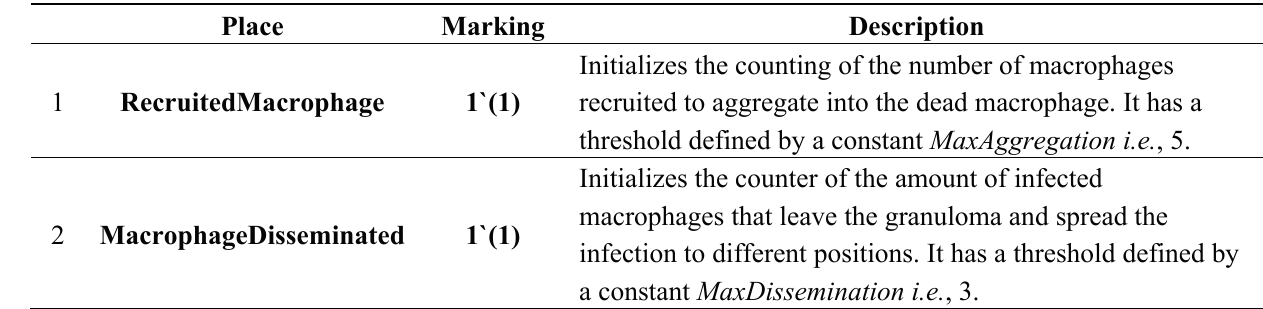
Table 5. Condition markings initially defined in the colored Petri net